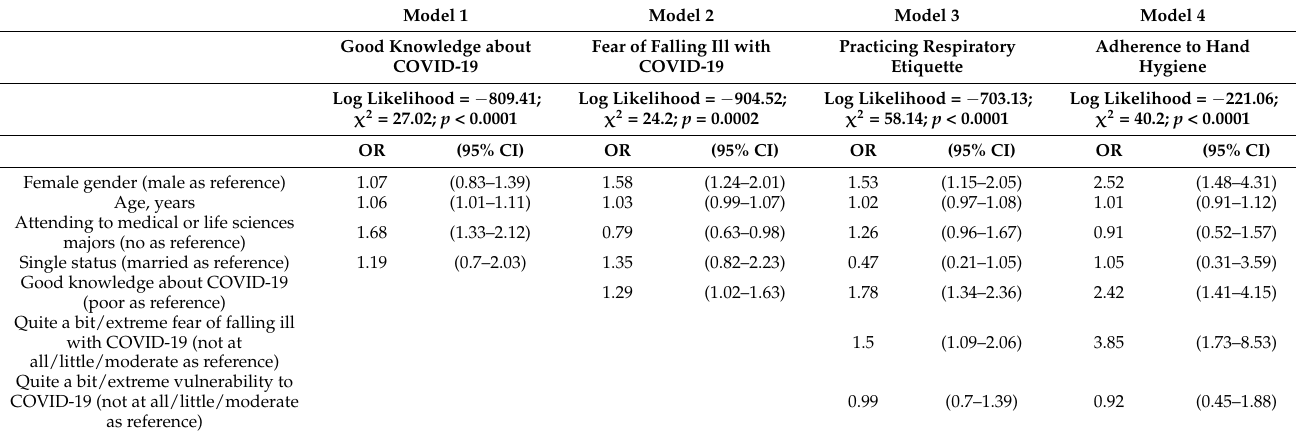
Table 2. Multiple logistic regression models for potential determinants of the different outcomes of